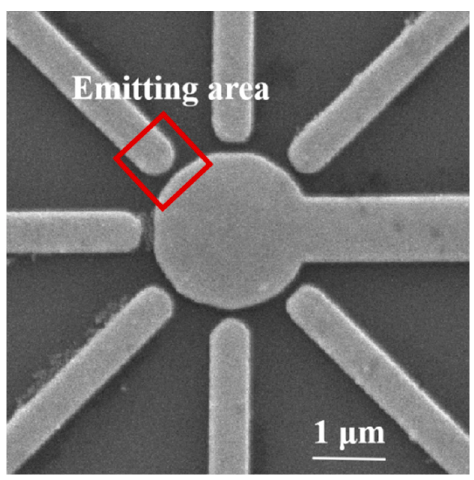
Figure 10 . SEM image of the emitting area of the NVC structure. Table 3. Electric characteristics for the emitting area. Table 3. Electric characteristics for the emitting